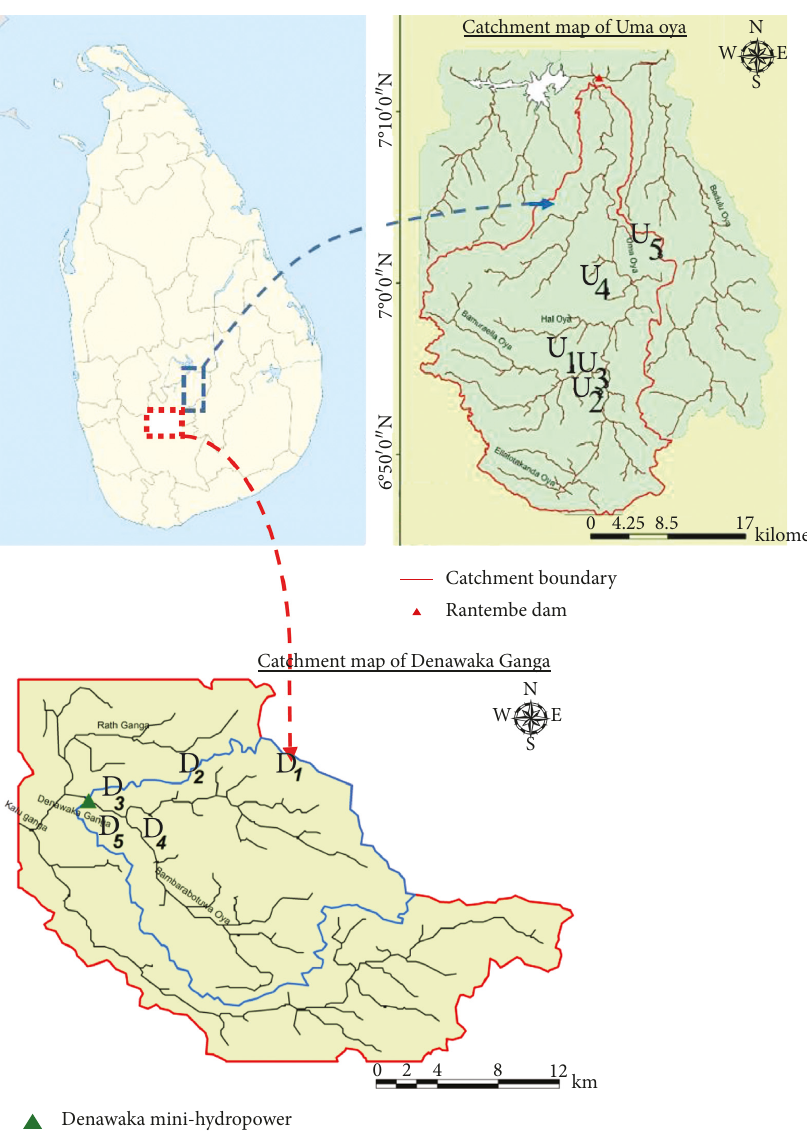
Figure 1: Uma Oya and Denawaka Ganga catchments.